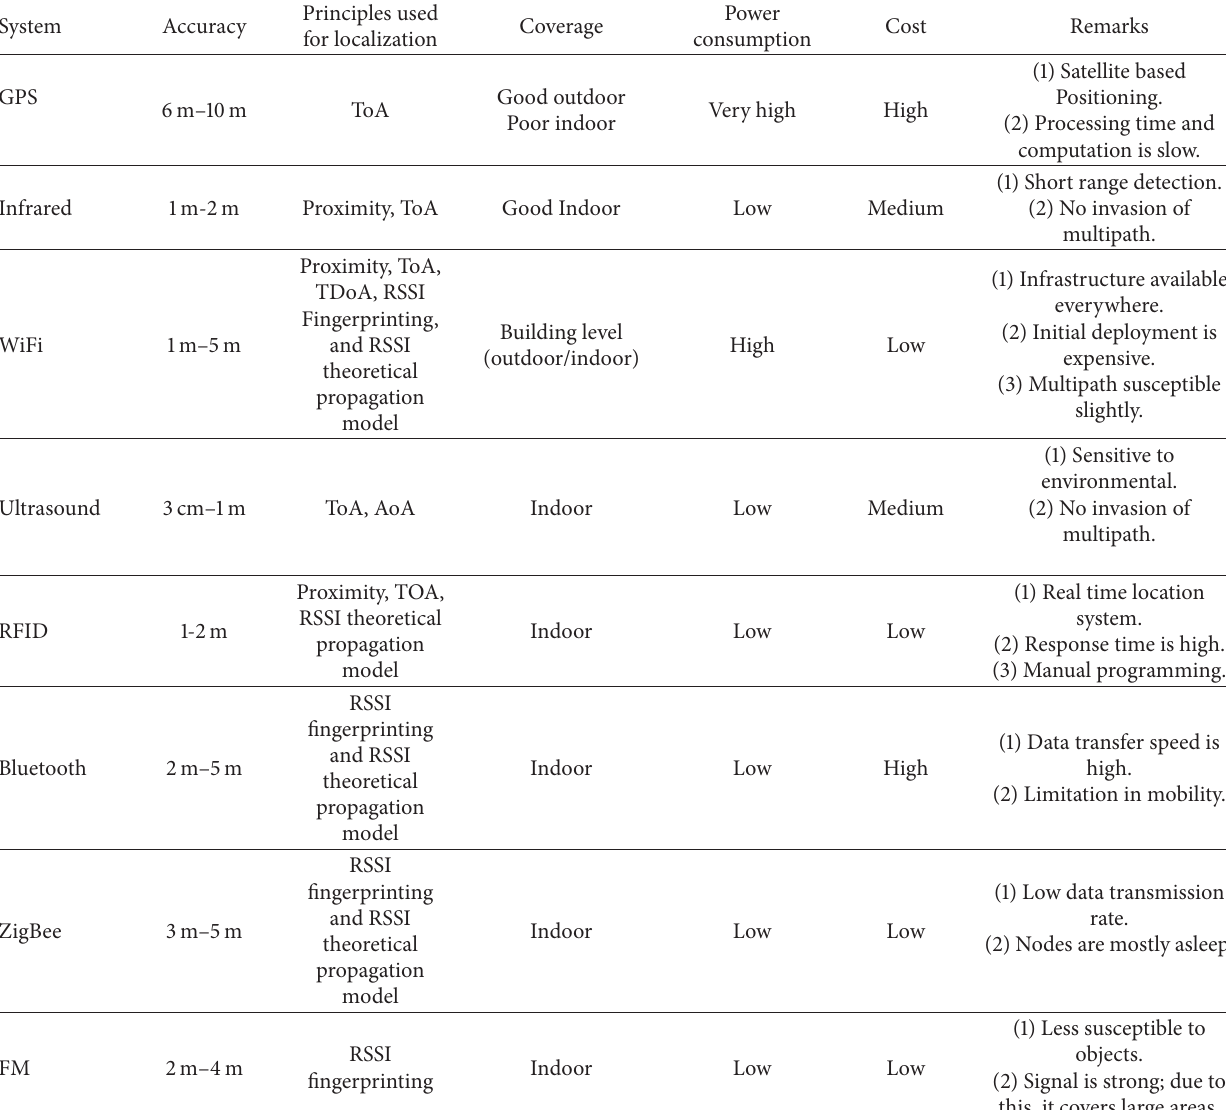
Table 3: Comparison of common position systems used for